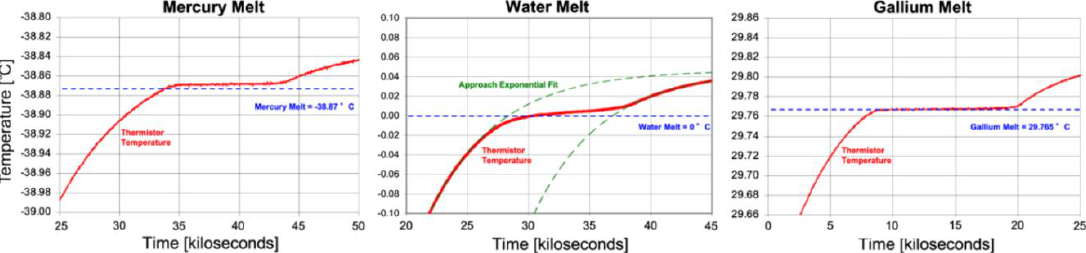
Figure 20. Melts of mercury, water, and gallium obtained using the ARI Prototype OARS. Each melt